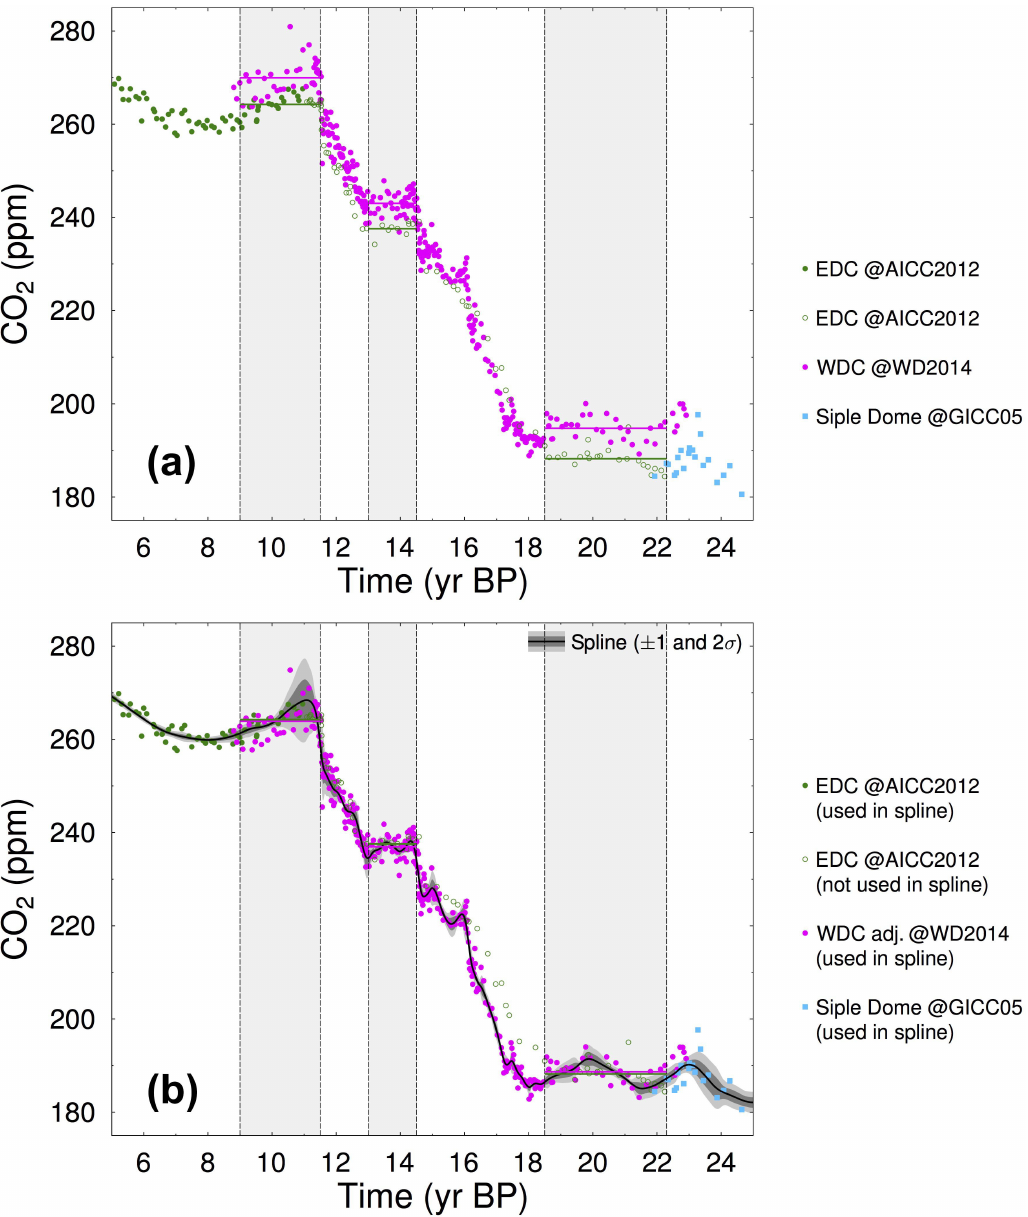
Figure A2. Details of differences between CO 2 of EDC (Monnin et al., 2001, 2004) and WDC (Marcott et al., 2014) during Termination I, showing how the adjustment of the WDC has been calculated. Grey areas mark the three time windows with relatively stable CO 2 from which the difference in CO 2 to both records has been determined. Horizontal lines mark the mean values for the different ice cores (green: EDC; magenta: WDC). The duration-weighted mean offset between the WDC and EDC of 6.06ppm is subtracted from the WDC data in (b)